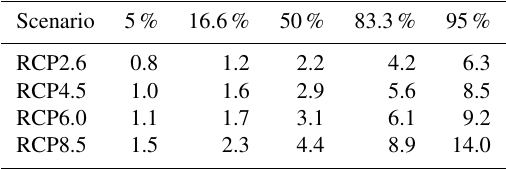
Table 12. Sea level rate contributions from basal ice shelf melting from Antarctica in 2100 from all models for the different emission scenarios in millimetres per year or centimetres per